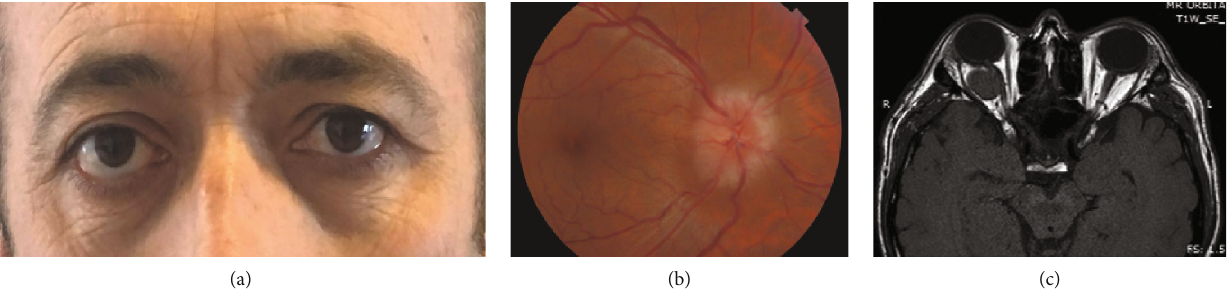
Figure 1: (a) Facial appearance of the patient at presentation. (b) Color fundus photograph of the right eye shows prominent optic disc edema and subtle macular compression. (c) Orbital T1-weighted axial magnetic resonance imaging shows an intraconal tumor isointense to the extraocular muscles producing compression of the globe and indenting the optic nerve.